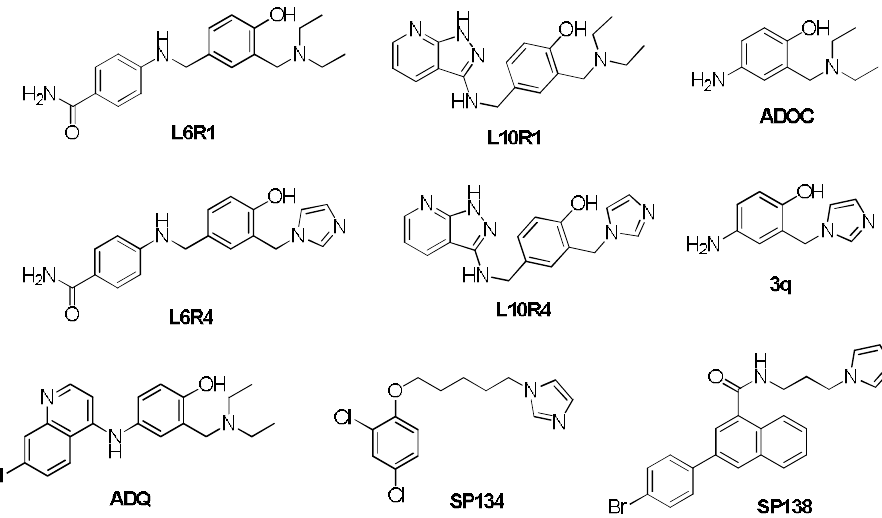
Figure 2. Chemical structures of non-oxime reactivators.